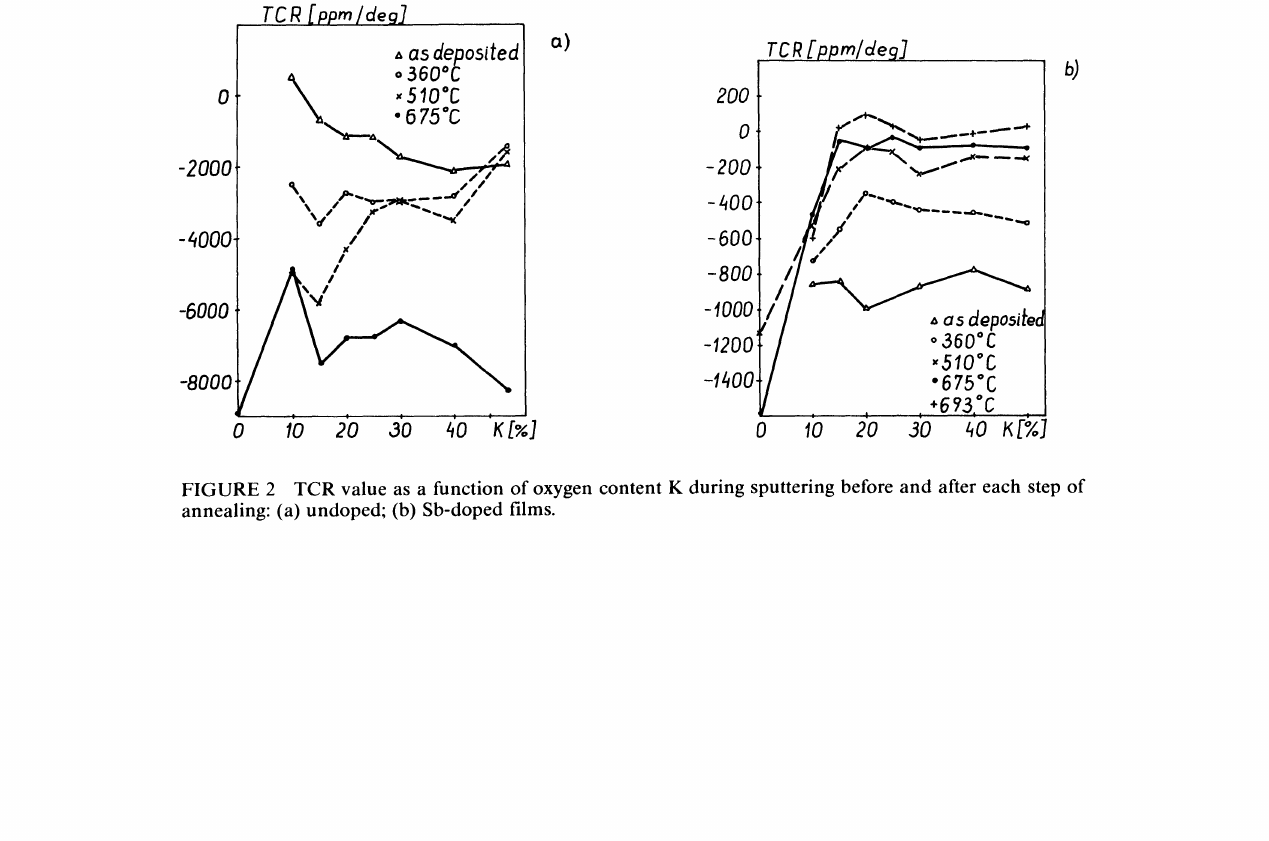
FIGURE 2 TCR value as a function of oxygen content K during sputtering before and after each step of annealing: (a) undoped; (b) Sb-doped